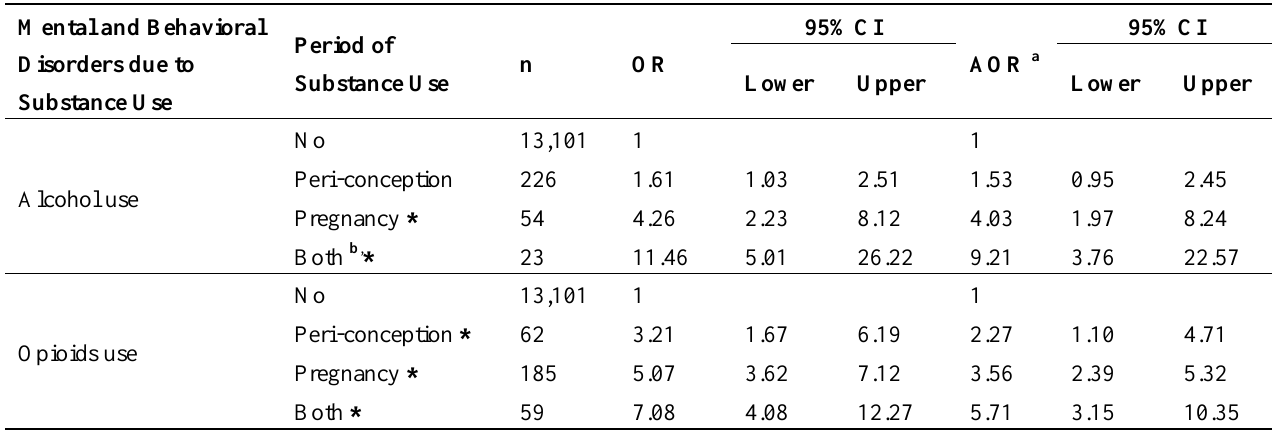
Table 2. Mental and behavioral disorders due to substance use in peri-conception and pregnancy and low